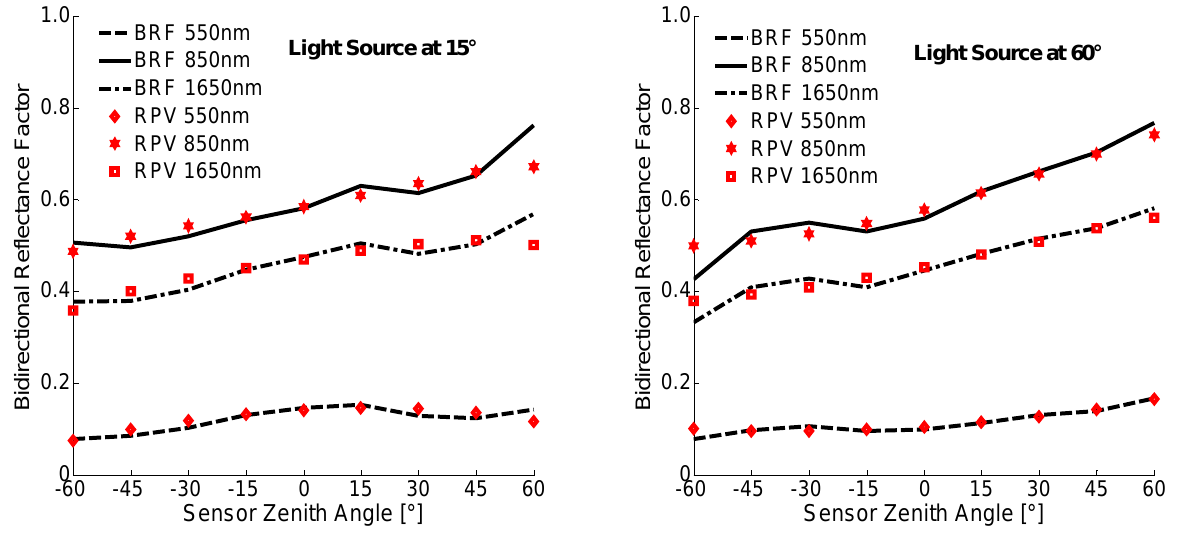
Figure 5 . Principal plane of the Bidirectional Reflectance Factor for measured reflectance and RPV estimations for the wavelengths of 550 nm, 850 nm, and 1,650 nm.